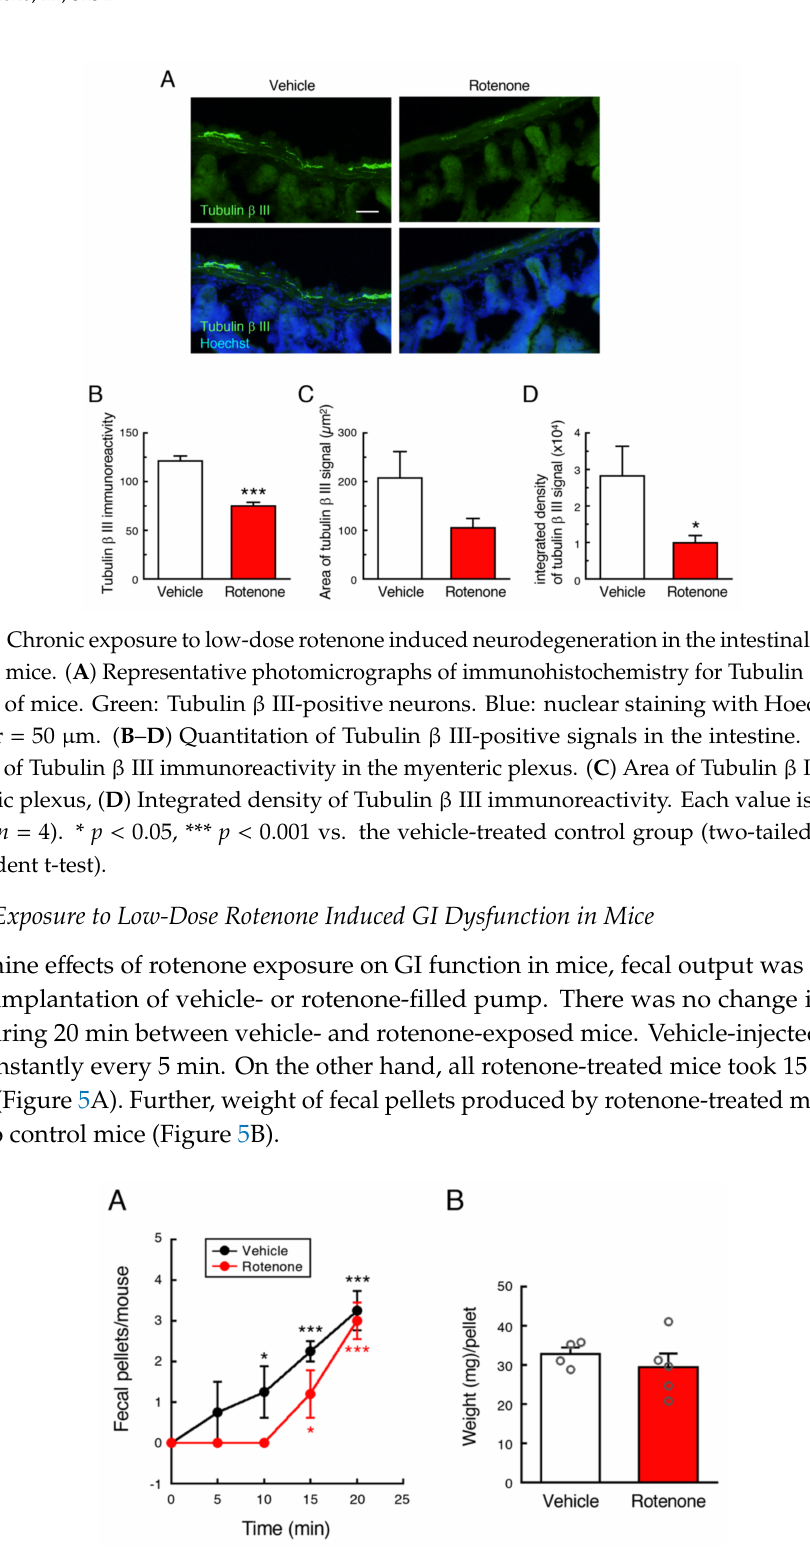
Figure 5. Chronic exposure to low-dose rotenone induced GI dysfunction in mice. Fecal output was measured at 4 weeks after implantation of vehicle- or rotenone-filled pump. ( A ) Time course of fecal outputs over 20 min. Each value is the mean ± SEM (Vehicle: n = 4; Rotenone: n = 5). ( B ) Weight (mg) of feces per pellet. Values are presented as dot blots with individual value plus bar with mean ± SEM (Vehicle: n = 4; Rotenone: n = 5). * p < 0.05, *** p < 0.001 vs. value at 0 min (one-way ANOVA followed by Fisher’s LSD